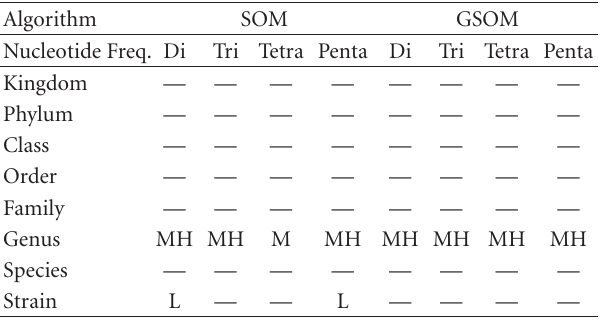
Table 5: Training results in the mixing regions for the contigs ≥ 8kb from simMC